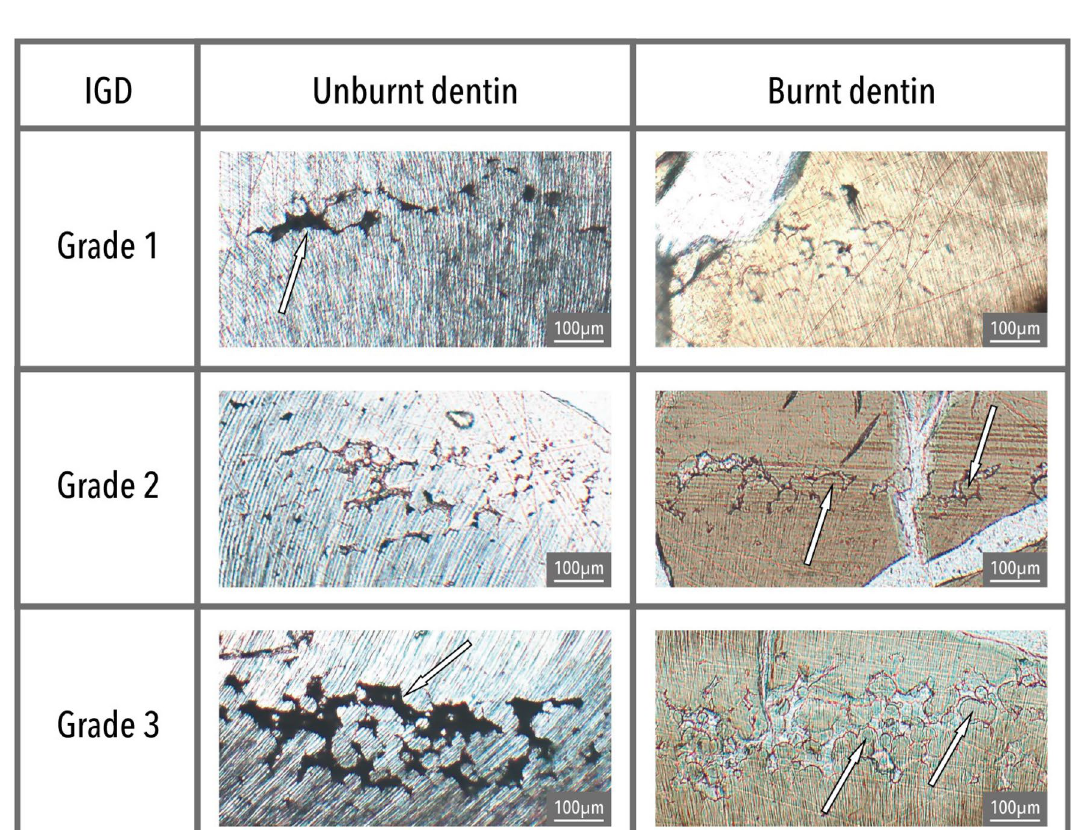
Figure 2. IGD appearance in unburnt (dark semi-circular spaces, see arrows) and burnt dentine (separately visible globules, calcospherites, see arrows). Burnt dentine Grade 1 is depicted in dentine burned at 800 °C (2 h), visible as dark semi-circular spaces, Grade 2 in dentine burned at 900 °C (2 h), and Grade 3 in dentine burned at 600 °C (2